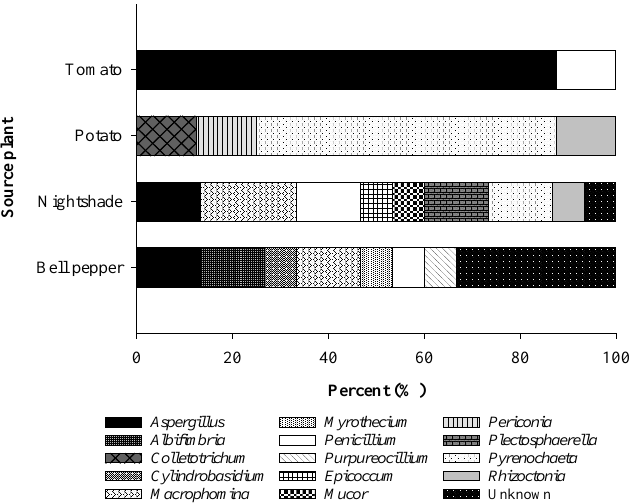
Figure 4. Comparative distribution of taxa with antagonistic activity against P. infestans from four solanaceous plant species.